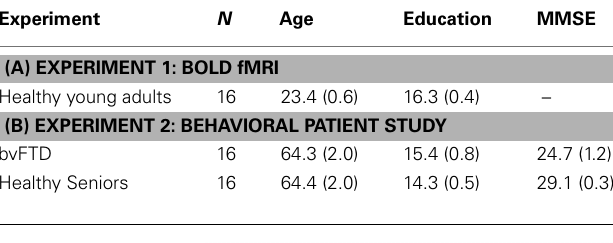
Table 1 | Mean (Standard Error) demographic characteristics of (A) healthy young adults in the functional MRI experiment (Experiment 1) and (B) healthy seniors and behavioral variant frontotemporal dementia (bvFTD) patients from behavioral Experiment 2.